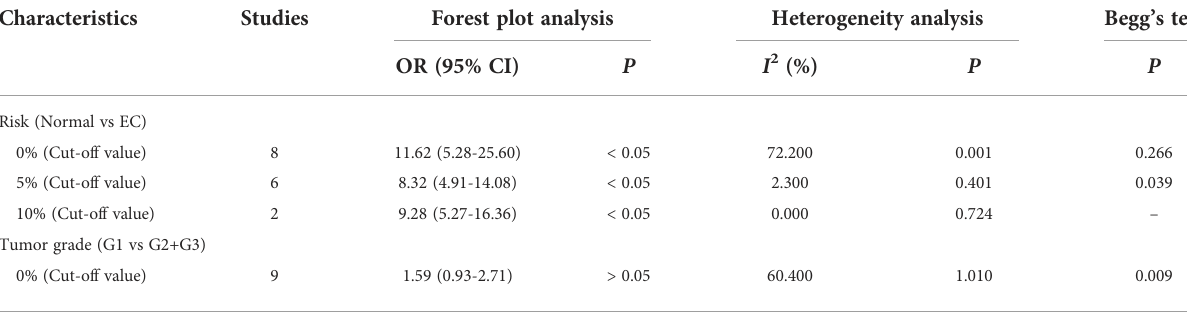
TABLE 3 The subgroup analysis based on cut-off values of MMP-9 expression for the risk and clinical features of EC. Characteristics Studies Forest plot